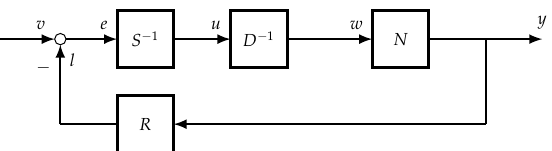
Figure 2. The right coprime factorization for an SISO